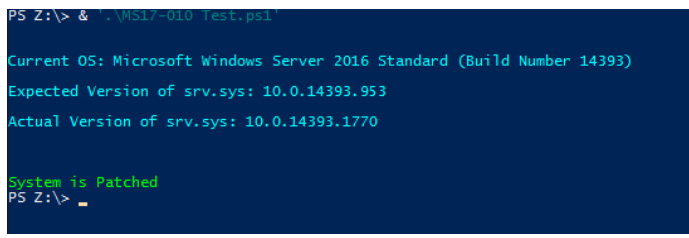
Figure 4. Output of PowerShell script stating patch